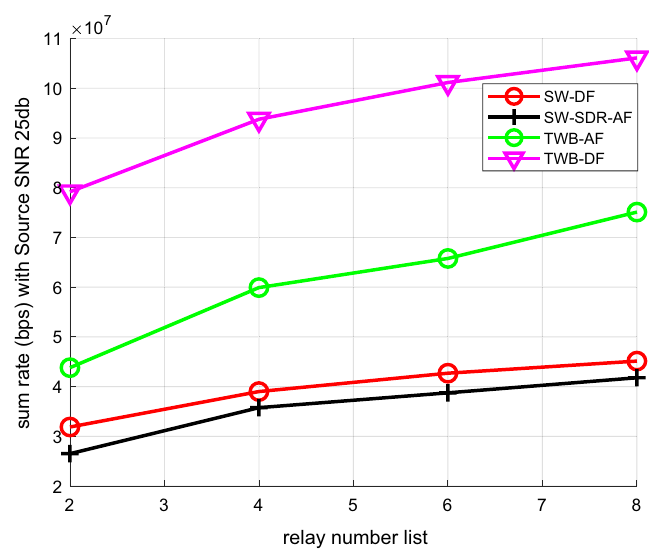
Fig. 9 Sum-rate curves with transmit power 25 db. It compares the sum rate of different cooperative schemes with different number of relays, and source transmit SNR is 25 db